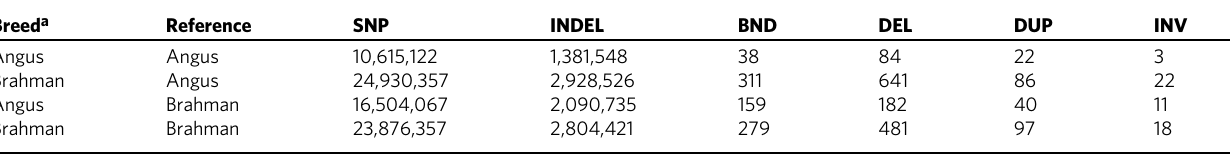
Table 2 Polymorphism